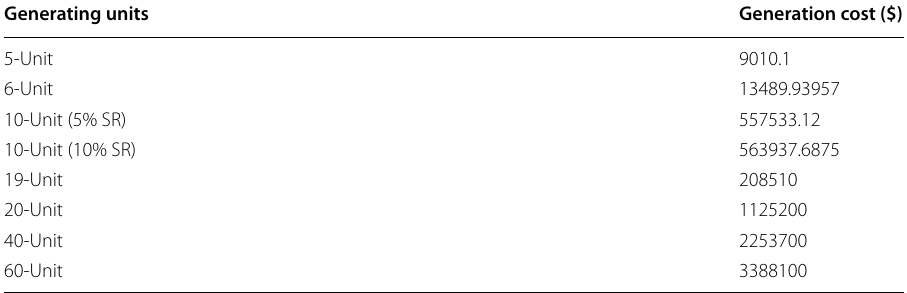
Table 22 Overall cost for generation of each unit without renewable energy sources Generating units